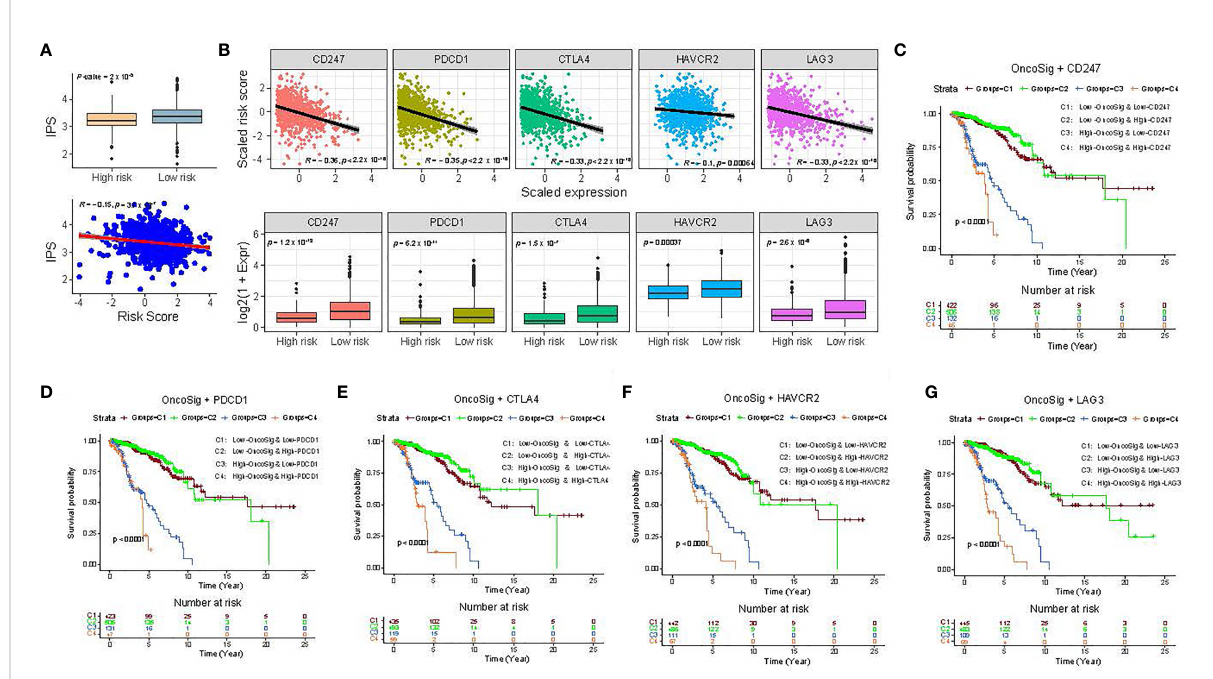
FIGURE 6 Impact of immune checkpoint gene expression and OncoSig on clinical outcome. (A) Comparison of the relative distribution of immunophenoscores (IPSs) between low- and high-risk groups in the TCGA-BRCA cohort (top). The scatter plot shows the correlation between the correlated IPS score and the OncoSig score, while R indicates the Pearson correlation coef fi cient (bottom). (B) Comparison of the expression pattern of immune checkpoint (ICI) genes between patients with higher and lower OncoSig scores in the TCGA-BRCA cohort. (C-G) KM OS curves for the four groups strati fi ed by the OncoSig and CD247 (C) , PDCD1 (D) , CTLA4 (E) , HAVCR2 (F) , and LAG3 (G) . The Wilcoxon rank-sum test was used for the statistical